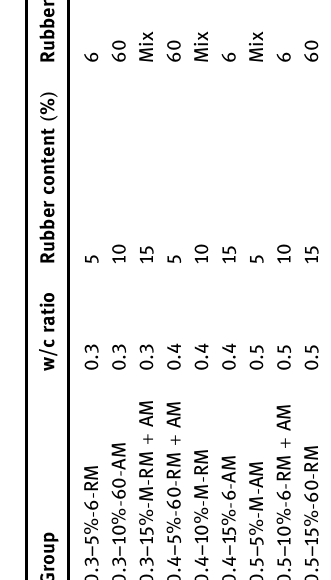
Figure 12: Stress – strain curve of